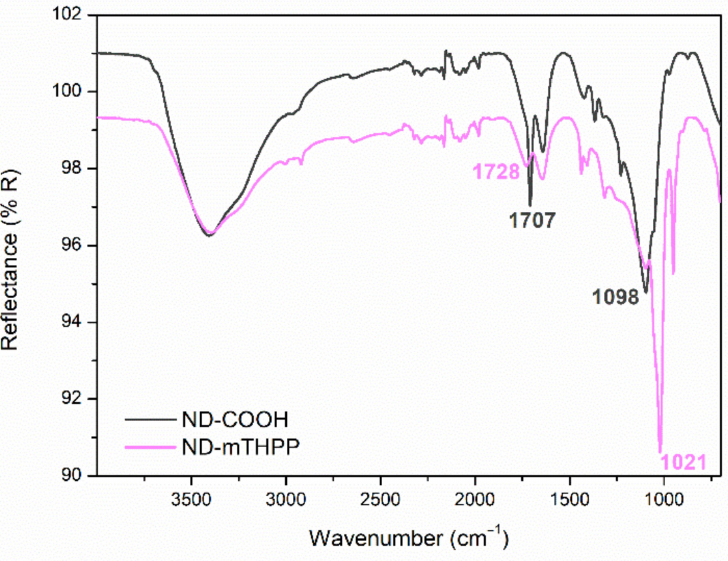
Figure 2. FT-IR spectroscopy ND-COOH and conjugated system (ND-mTHPP). Similar results were obtained by Matshitse et al. (2019) [40] who reported on the for- mation of conjugate system between detonation nanodiamond and ZnTPPcQ by a covalent bond. The conjugation by covalent bond was confirmed by FT-IR, wherein it was observed the shift of the band close to 1700 cm − 1 (attributed to the stretching vibrational mode of the C=O bond of the carboxylic group present in the ND surface) to the region around of 1600 cm − 1 , that could be associated with the presence of RCOOR, due to the formation of the covalent bond of the phthalocyanine hydroxyl group and the carboxyl groupd from ND. Recently, Tsolekile et al. (2020) [41] reported on the covalent bond between ternary quantum dots (CuInS/ZnS) capped with glutathione and mTHPP porphyrin, via an es- terification reaction as proven by the band at 1015 cm − 1 , in the FT- IR spectrum of the conjugate, which has been assigned to the vibrational mode of the C–O ester